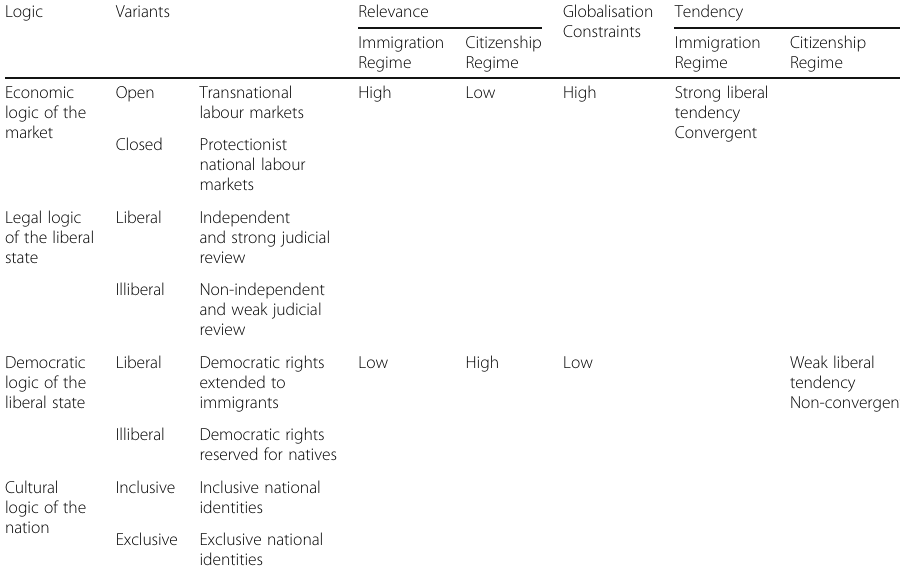
Table 1 Overview of the analytical framework and its empirical